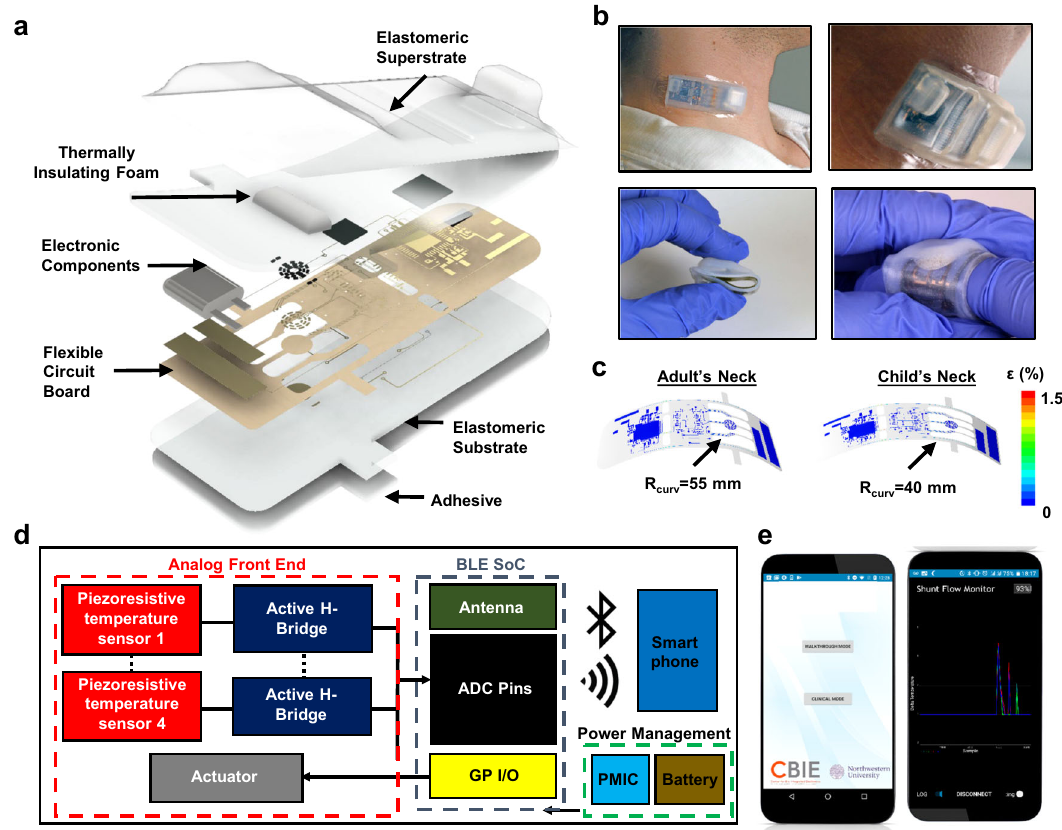
Fig. 1 Wireless sensors for continuous monitoring of CSF hydrodynamics through shunts. a Exploded view illustration of the device, highlighting the fl exible circuit board, electronic components, thermally insulating foam, elastomeric encapsulation and adhesive layers. b Optical images of devices illustrating their fl exible construction and ability to mount on the skin over anatomical regions relevant to VP shunts. c Finite element analysis (FEA) of the distributions of strain across the fPCB during bending to a degree comparable to that required to mount on the neck region of a child (radius of curvature = 40 mm) and an adult (55 mm). d Schematic illustration of the electronic design for actuation, data acquisition and wireless transmission. e Optical image of smartphone application used for wireless readout and communication. Participants provided written informed consent to have their photos/images included as a part of this